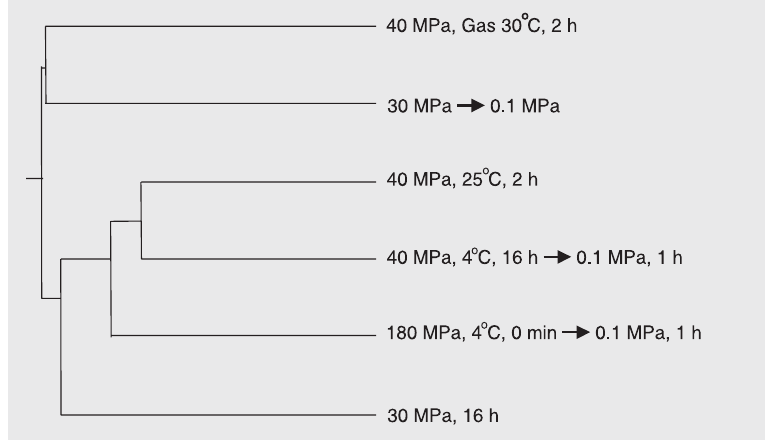
Figure 2. Cluster analysis of expression profiles following treatment of yeast with six different compressed gas pressures. A dendrogram was constructed to indicate the rela- tionship among the effects of each compressed pressure. Expression profiles based on 6335 spots were used for the